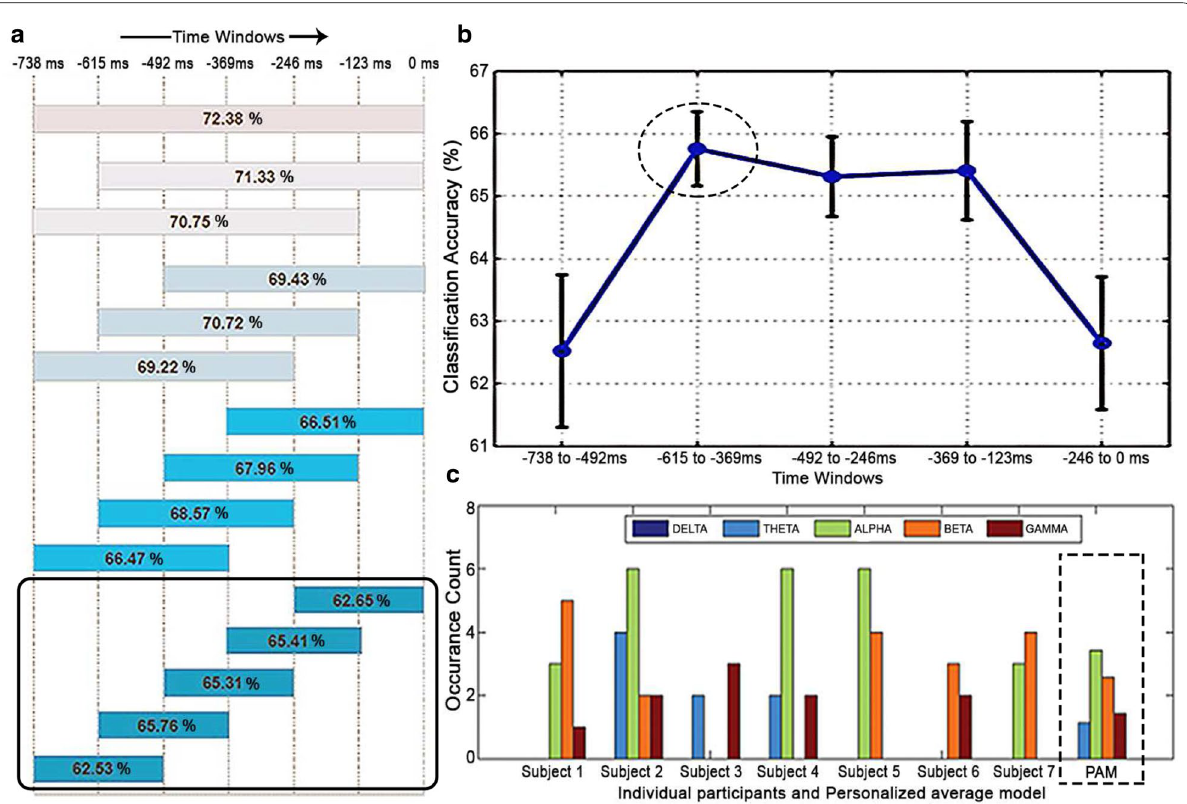
Fig. 9 Results of moving window analysis: a Arrangement for moving windows along with classification accuracy averaged over all subjects using DATFPS17 feature. b Error bar indicates SEM of individual subjects accuracies in this feature type over each moving window of 246 ms. Features of − 615 ms to − 369 ms window yielded the highest accuracy. c For this time window, band-wise occurrence count of dominant features for each subject and PAM using DATFPS17 feature type is